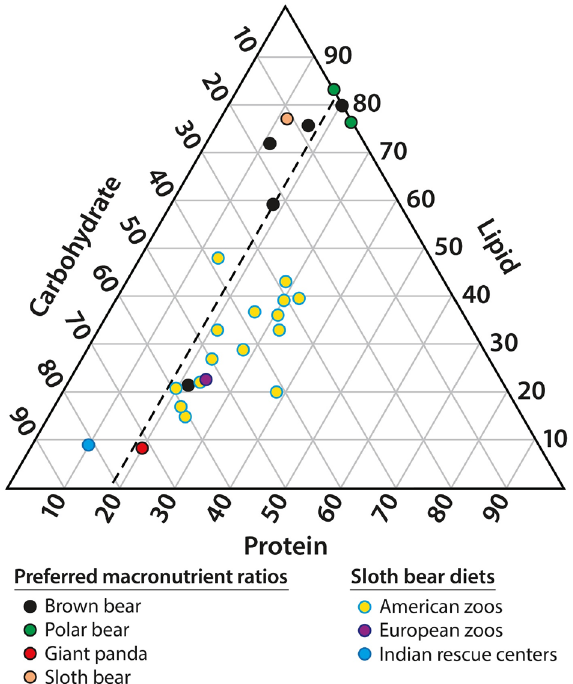
Figure 3. Distribution of the metabolizable energy ratios (%) selected by captive brown bears, giant pandas, sloth bears, and captive and wild polar bears. The giant panda point is for when digestible carbohydrates in bamboo were most available in the current study (i.e., January and March) and for diets fed in five Chinese zoos 32 . The dashed line is the average dietary protein concentrations selected by giant pandas, brown bears, polar bears, and sloth bears. These macronutrient preferences by ursids are in comparison to the macronutrient ratios in sloth bear diets in American zoos (e.g., Cleveland, Little Rock, Seattle, San Diego, Miami, and Philadelphia), European zoos (average for 26 zoos), and Indian rescue centers 3,4,22 . When multiple diets were submitted by American zoos, they were analyzed and are shown